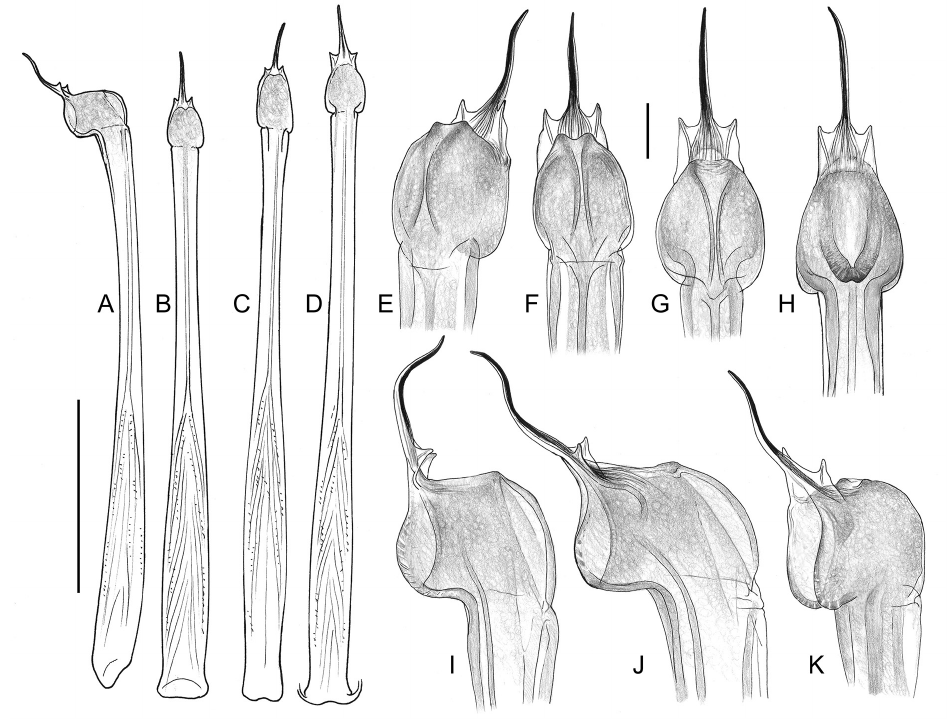
Fig. 20. Dicranopalpus pyrenaeus Dresco, 1948. Penis. A . Lateral view. B . Ventral view. C – D . Dorsal